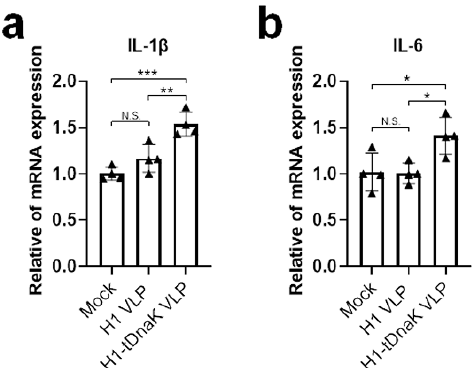
Figure 3. Analysis of the biological activity of membrane-anchored C-terminal domain of DnaK in vitro. Human lung carcinoma cell line A549 cell cultures were mock-treated with PBS or treated with NC99 H1 VLPs and NC99 H1-tDnaK VLPs, respectively. Cell cultures were collected 24 h after treatment for transcription analysis, and then total RNA from cell samples was extracted and reverse-transcribed into cDNA immediately. The gene transcription levels of ( a ) IL-1 β and ( b ) IL-6 were quantified by qPCR. The results were presented as means with standard deviation ( n = 4 per group). Each triangle symbol represents the relative value of cytokine mRNA expression level of each VLP-treated or mock-treated cell culture sample. Statistical significance was analyzed by t -test; *, **, and *** represent p < 0.05, p < 0.01, and p < 0.001, respectively. N.S. indicates no significance.